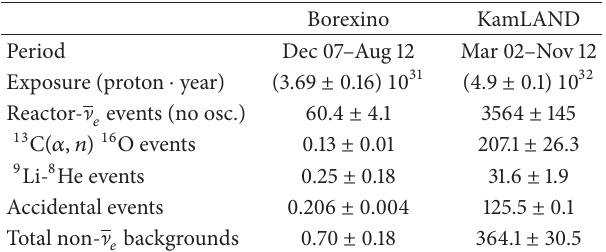
Table 3: The most important backgrounds in geoneutrino measure- ments of Borexino [62] and KamLAND [51].